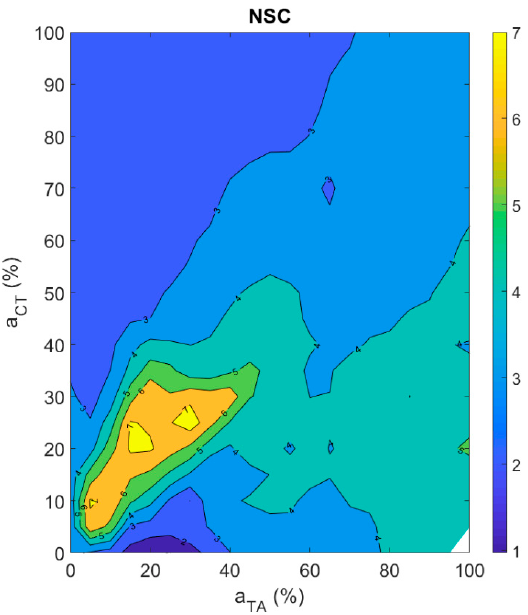
Figure 8. Muscle activation plot with normalized spectral centroid (NSC) as the contour feature.